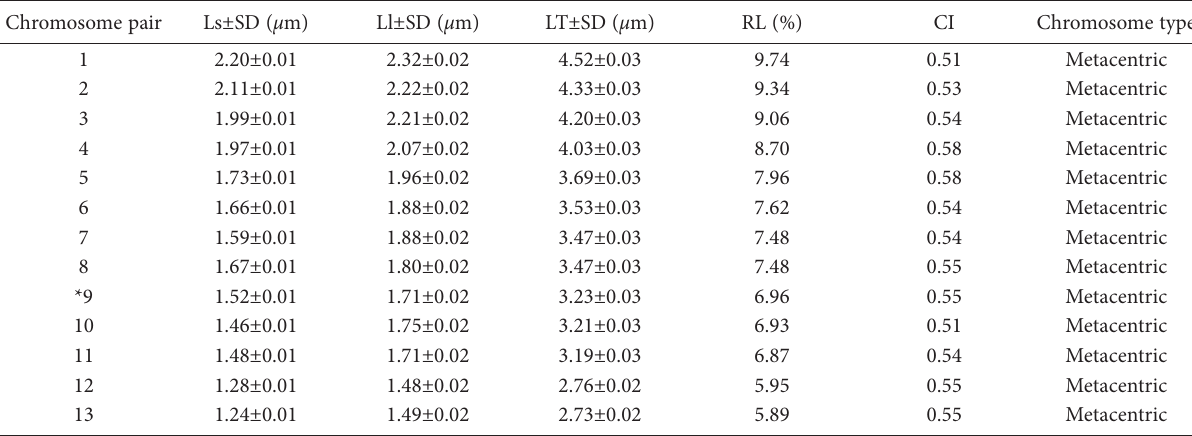
*=satellite chromosome.